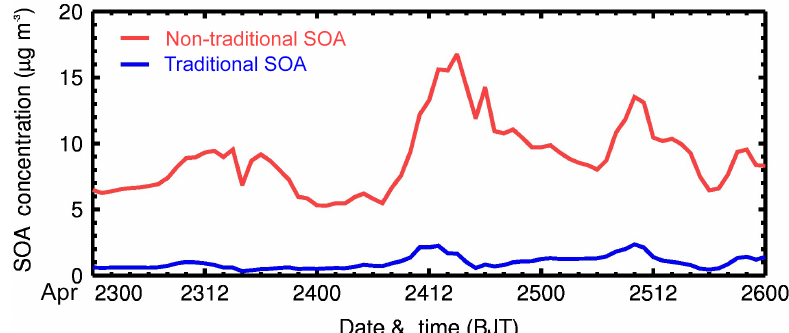
Figure 11. Temporal variations of the simulated SOA concentrations from the traditional (blue spots) and non-traditional (red spots) SOA modules in Xi’an and surrounding areas from 23 to 25 April